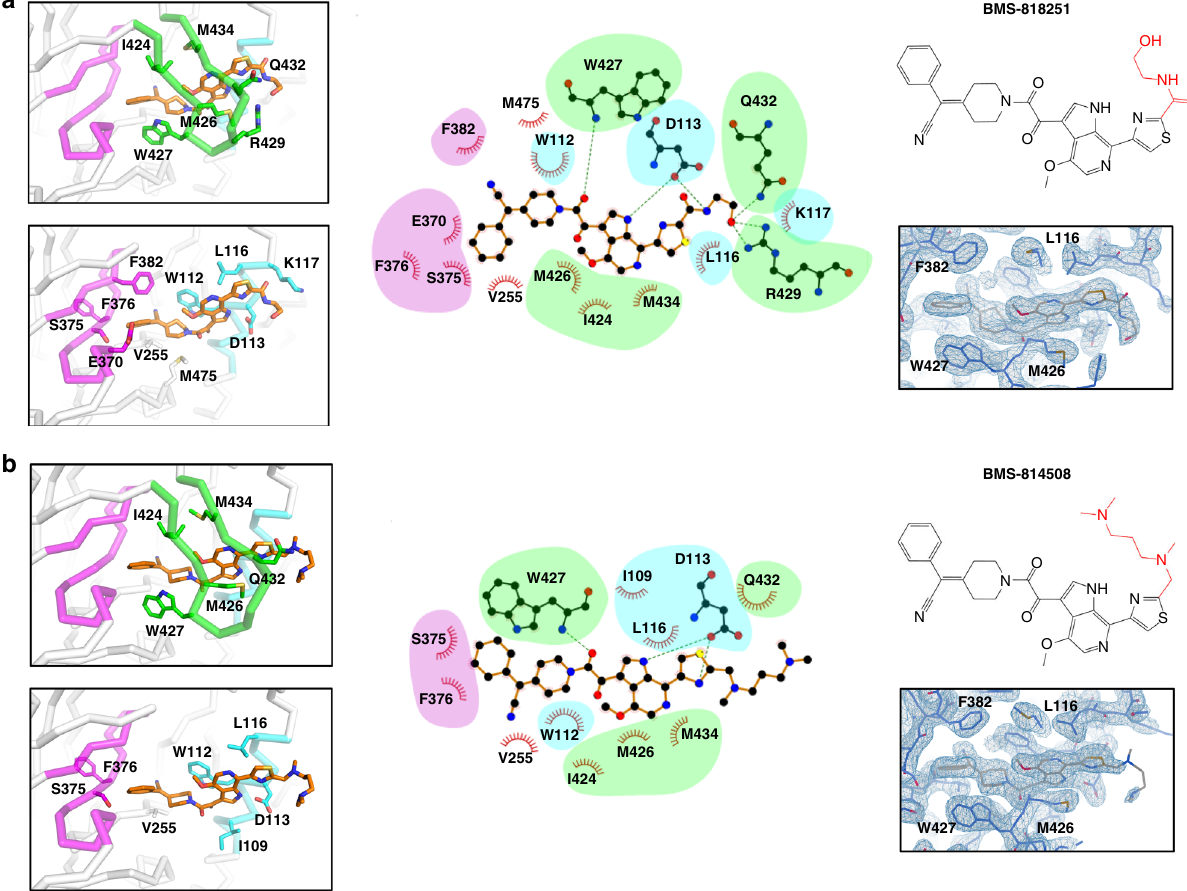
Fig. 4 Crystal structures derived from improved lattice reveal molecular features associated with enhanced neutralization potency. a The complex structure of BMS-818251 with BG505 SOSIP.664 Env trimer is shown in the top panel on the left with interacting residues on the β 20 − β 21 hairpin (green segment) shown as sticks and labeled; interacting residues other than those on the β 20 − β 21 hairpin are shown as sticks and labeled in the lower left panel. BMS- 818251 is shown as orange sticks. Middle, BMS-818251 interaction with BG505 SOSIP.664 Env trimer is shown as a 2D plot, with residues belonging to the three major fragments colored accordingly. Top right, the chemical formula of BMS-818251 ; bottom right, 2Fo-Fc electron density map surrounding the inhibitor binding pocket is shown as blue mesh, contoured at 2 σ . b Crystal structure (left), 2D plot (middle) and electron density map (bottom right) of BMS-814508 (top right) shows the interaction between the inhibitor and BG505 SOSIP.664 Env